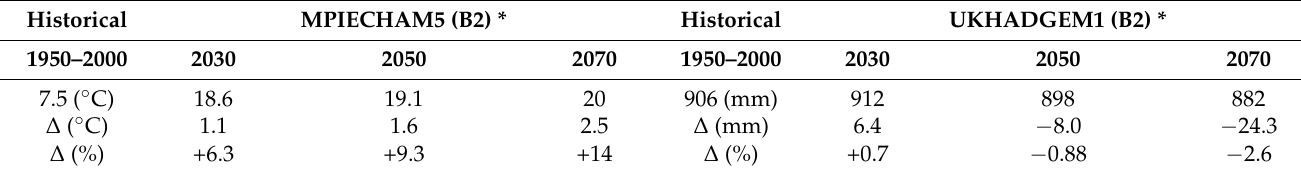
Table 4. Trend and difference in temperature and precipitation of emission scenario B2 in the DRB.